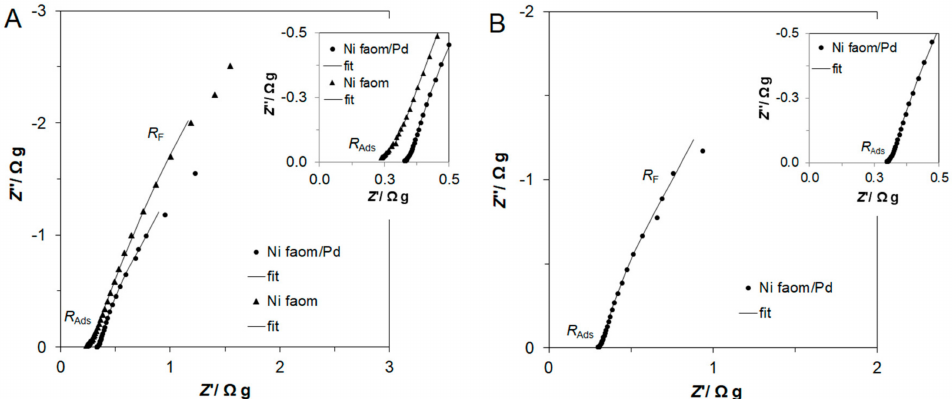
Figure 6. ( A ) Complex-plane impedance plots for resorcinol electrooxidation on Ni foam and Pd-modified Ni foam electrode surfaces in contact with 0.1 M NaOH solution, recorded at room temperature for a potential value of 1200 mV vs. RHE. The inset presents a magnification of the semicircle assigned to R Ads parameter for both electrodes. The solid lines correspond to a representation of the data according to equivalent circuit model shown in Figure 7; ( B ) as in ( A ), but for Pd-modified Ni foam electrode in contact with 0.5 M Na 2 SO 4